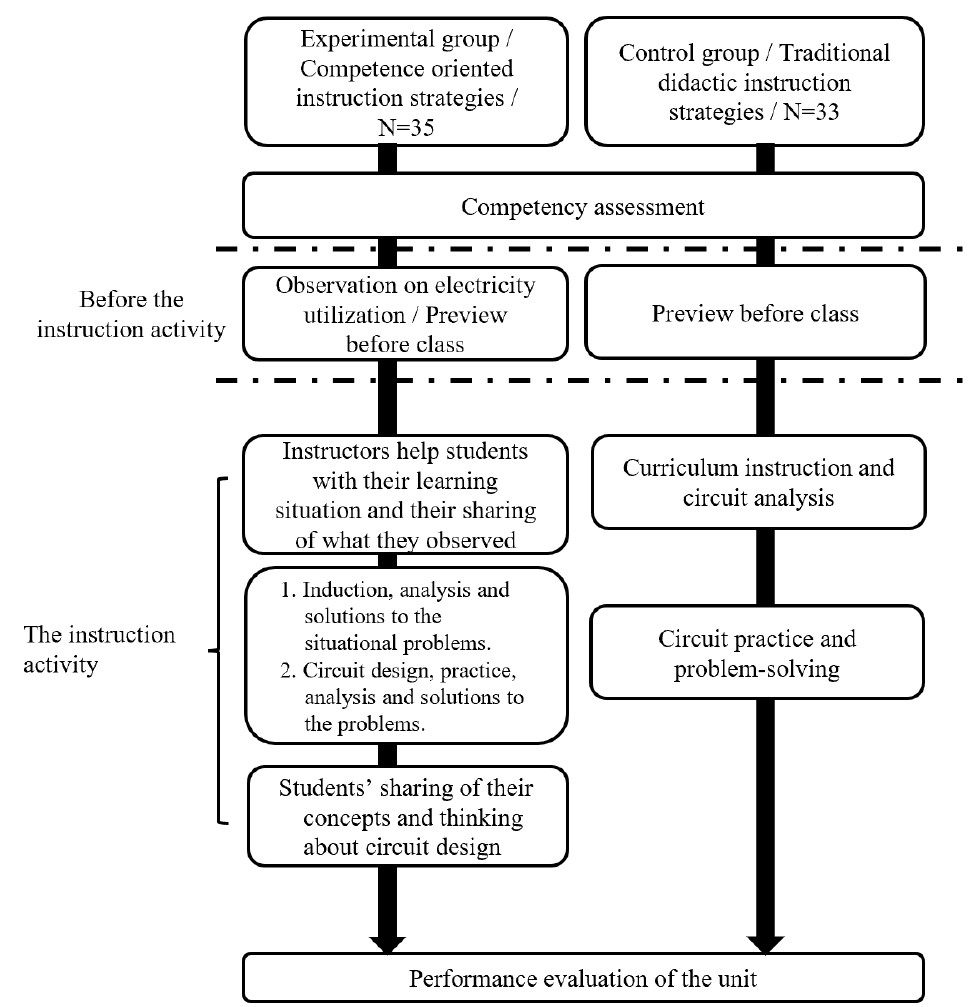
Figure 7. Process flow of experimental group and control group unit instruction implementation.